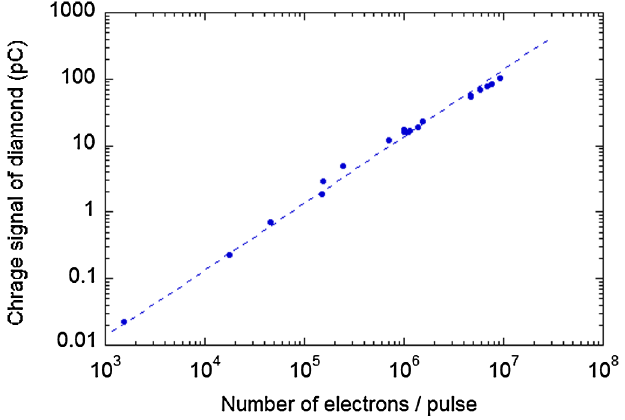
FIG. 5. Linearity of output signal.